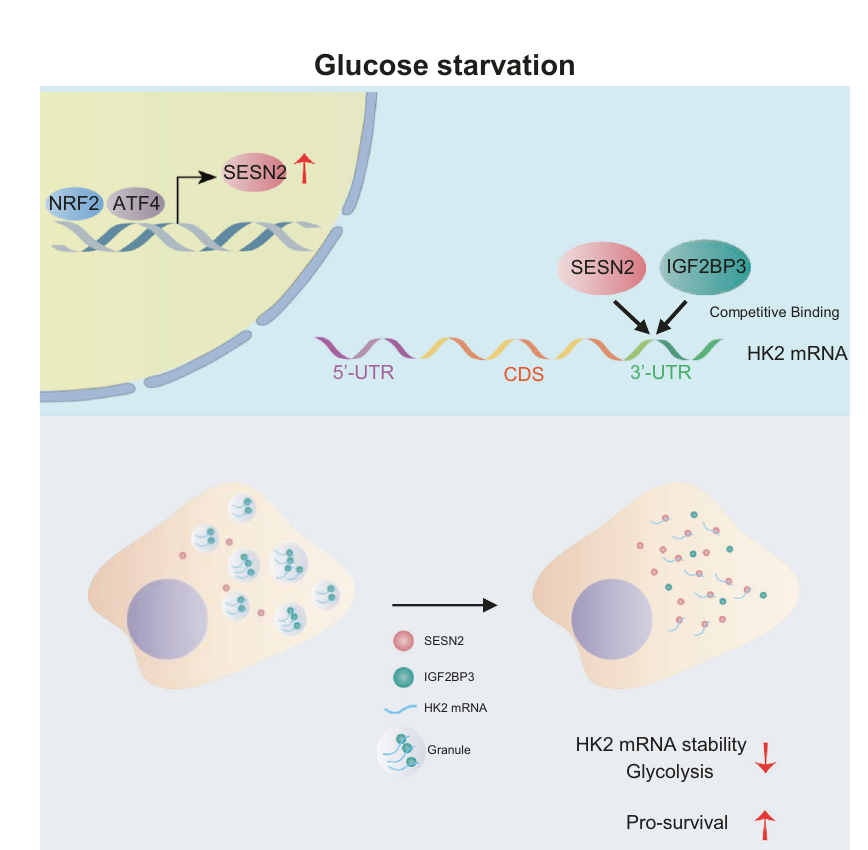
Fig. 6 Working model. HK2 mRNA stability is controlled via competitive interactions between SESN2 and IGF2BP3. with 4% skim milk. Thereafter, the membranes were incubated with primary antibodies overnight at 4 °C followed by horseradish peroxidase- conjugated secondary antibodies with detection using chemilumines- cence (Advansta#K-12045-D50). Alternatively, for immunoprecipitations, cell lysates prepared with IP buffer (0.5% NP-40, 20 mM Tris pH 7.4, 150 mM NaCl, 1.5 mM MgCl2, and protease inhibitor cocktail were incubated with primary antibodies adsorbed to protein A/G-Sepharose beads for 4 hours, washed fi ve times with IP buffer. Antibody sources/ dilutions are shown in Table S6.